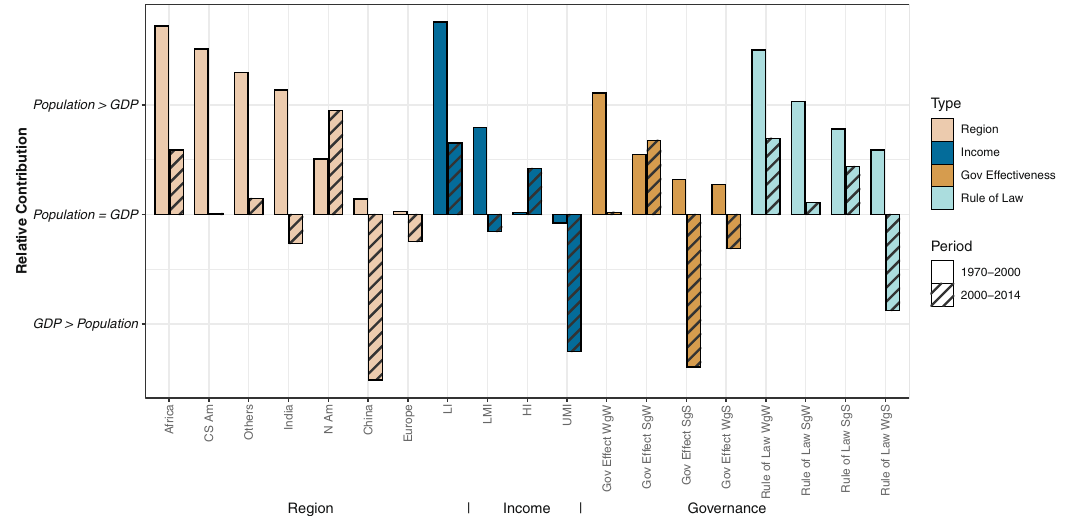
Fig. 5 Differences in the relative importance of population growth and GDP growth for ULE. Color on the bars represents the types of contexts (region, income, governance). First bar for each category represents the pre-2000 period and the one with dashed lines represents the post-2000